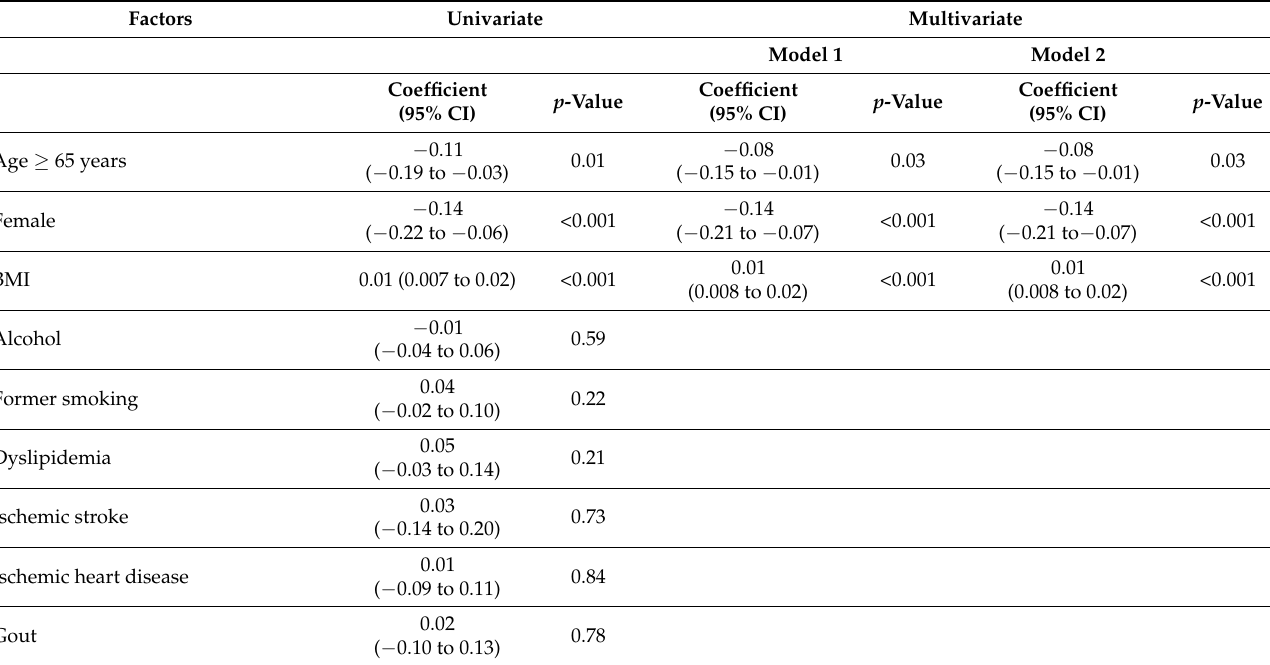
Table 3. Association of beta-blocker use and BMD of the total